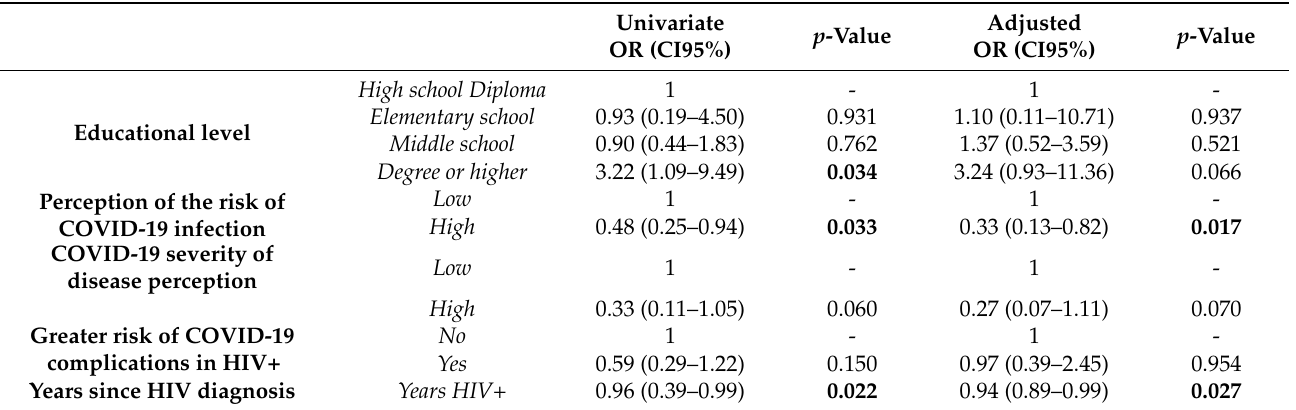
Table 3. Proactive search of information in the vaccination field (multivariate analysis) (N = 160) *.